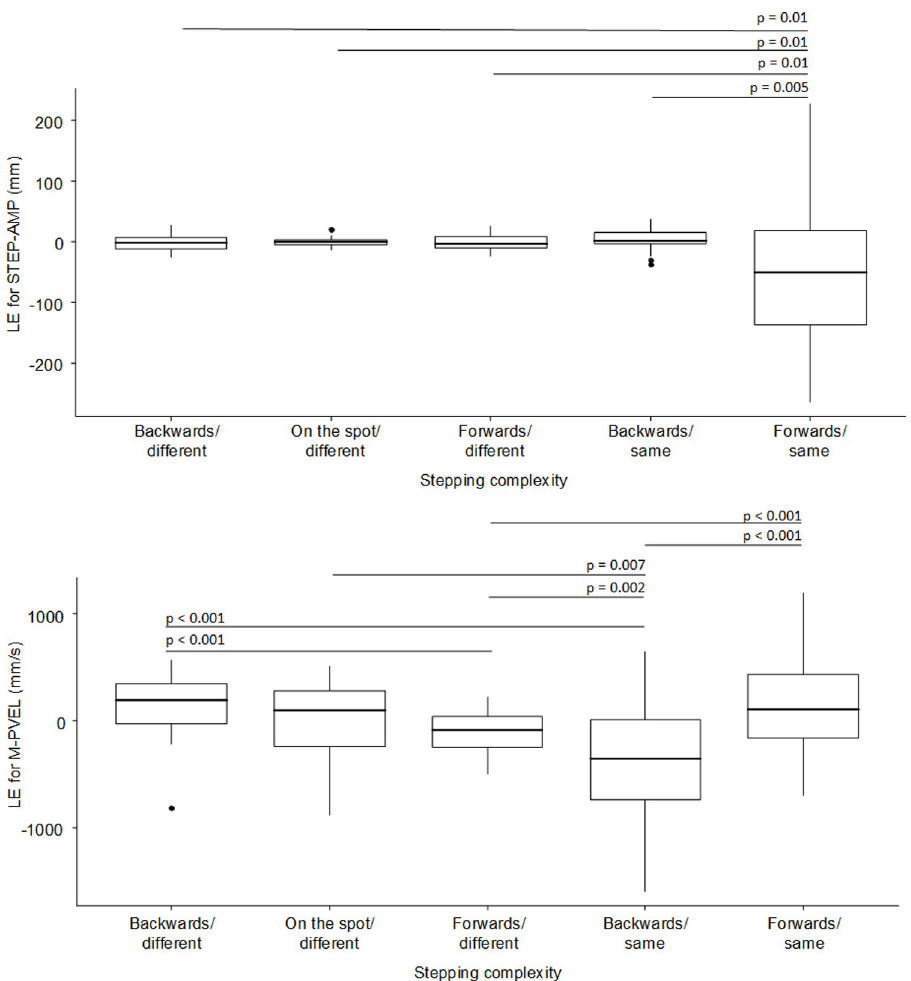
Fig 6. Box plots of the sequence learning effects for stepping amplitude (A; STEP-AMP) and average peak stepping velocity (B; M-PVEL) as a function of the direction of a step and the foot of the previous step. The whiskers of the boxes indicate variability outside the upper and lower quartiles. Relative outliers may be plotted as individual points.